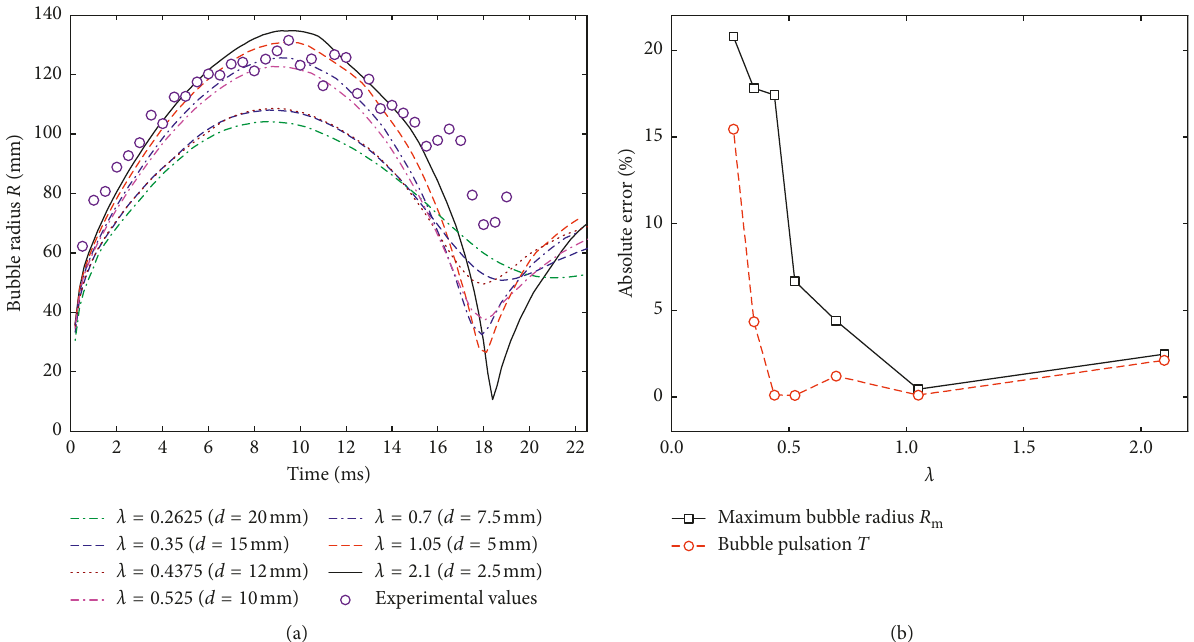
Figure 15: (a) Bubble radius R of the first pulsation period with time at different λ and (b) absolute error of R